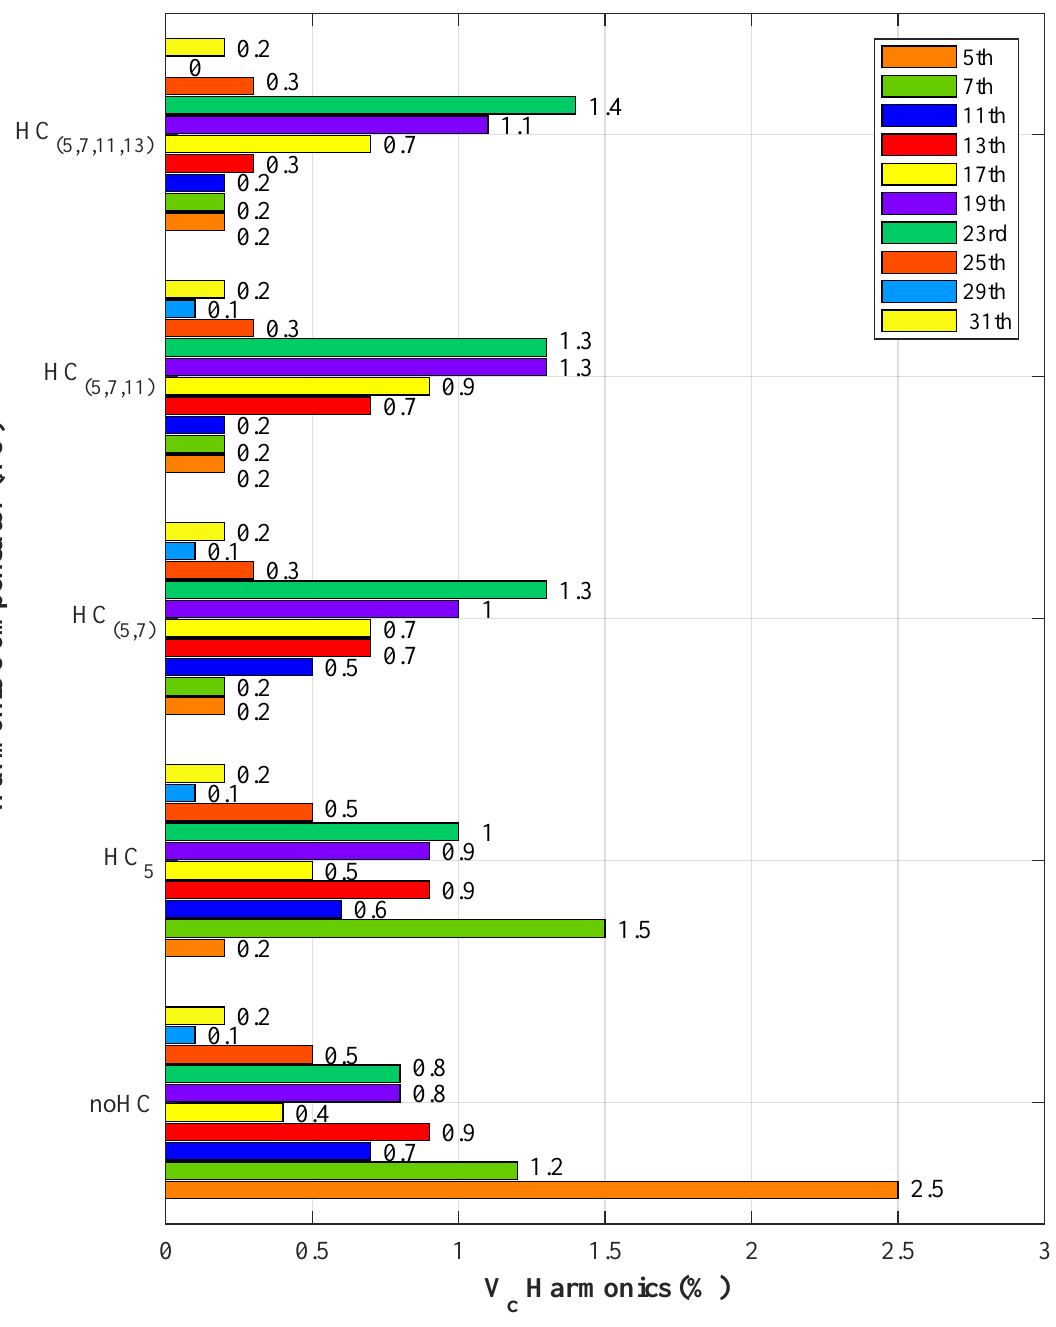
Figure 21. Harmonic V c content controlled by dSPACE 1006